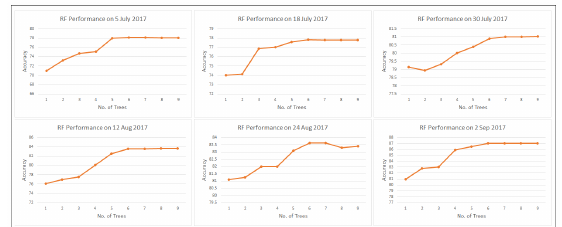
Figure 5. Average Accuracy using RF for Different Number of Trees